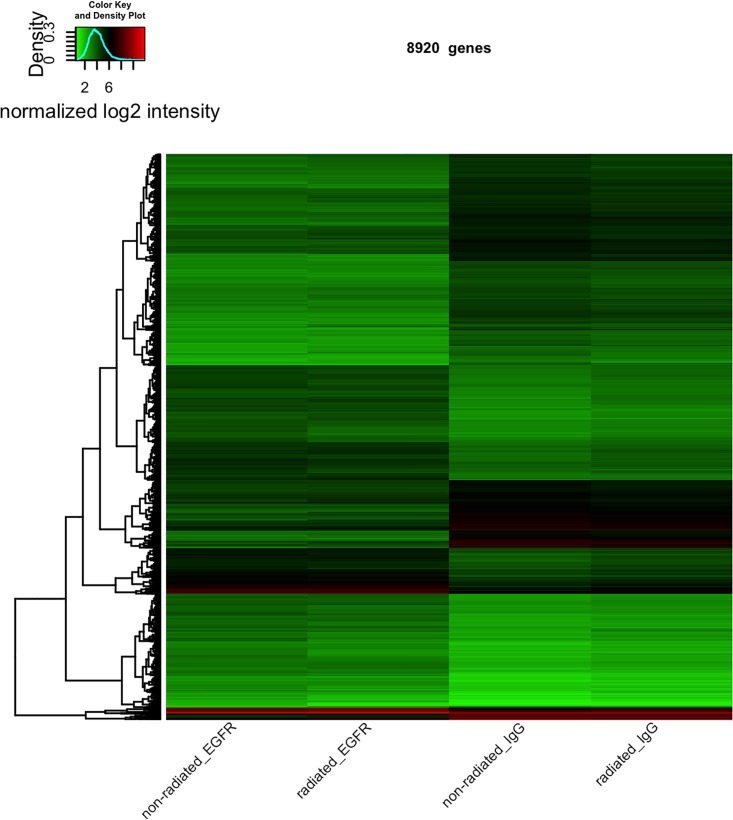
Heatmap-based visualization of the log2 normalized expression values.Heatmap displaying log2 expression ratios of the 8920 probes that were DE in non-irradiated cells that were immunoprecipitated with the EGFR antibody (first column) or IgG (third column)(p<0.05). We considered only oligos, which refer to genes and have in addition a log fold change either >+1 or < -1. Lower log2 ratios are indicated by a green color in the heatmap and higher log2 ratios are indicated by a red color. The dendrogram on the left side is based on Euclidean measures to obtain the distance matrix.